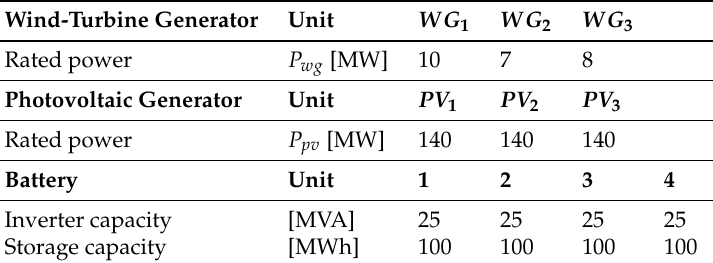
Table 3. Parameters of each